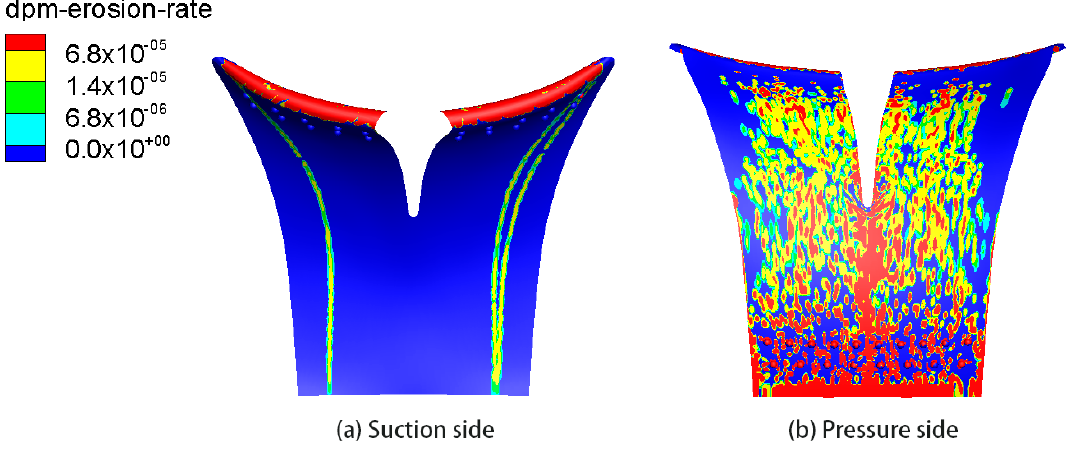
Figure 18. Silt erosion on blade surface with bionic convex domes (units: μ m/s, particle size: 0.2375 mm).